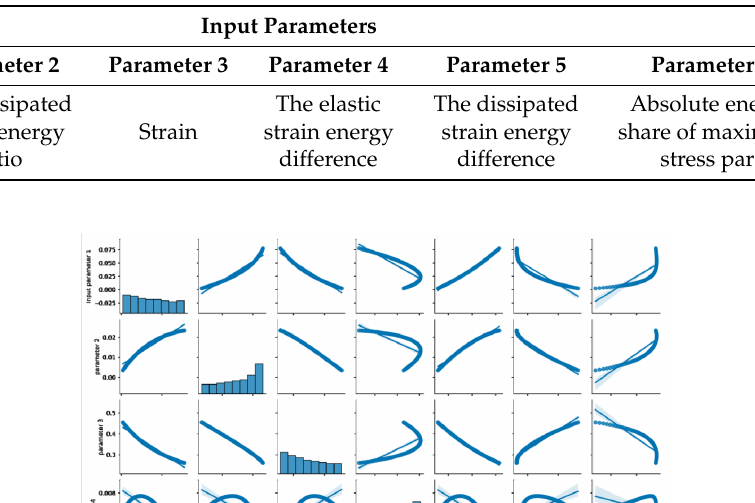
Table 1. Artificial intelligence parameters.